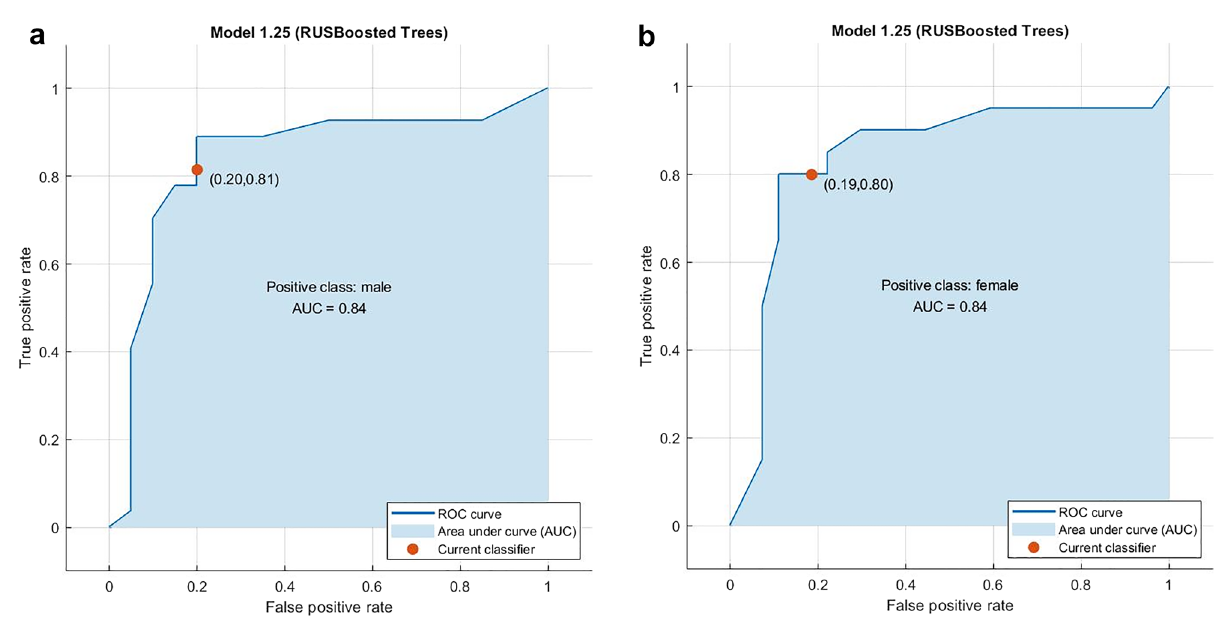
Figure 5. ROC analysis for male class ( a ) and female class ( b